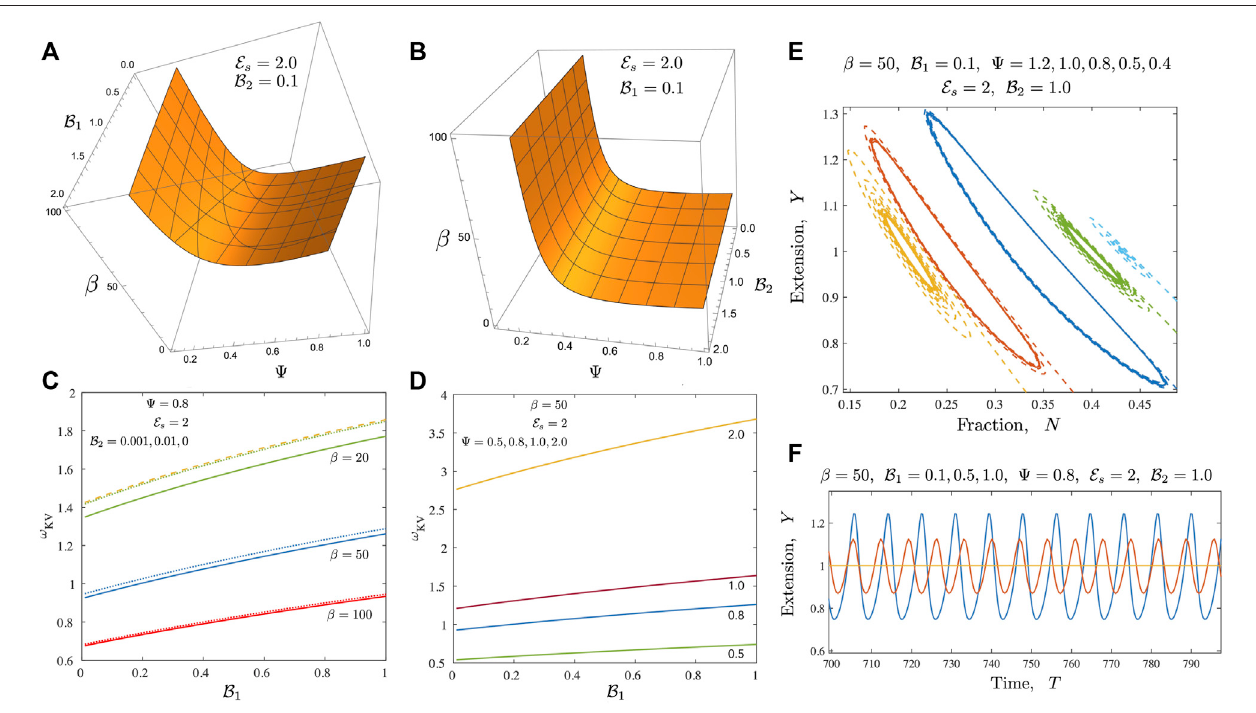
FIGURE 5 | Results for the case of a Kelvin-Voigt medium (A,B) Neutral stability curves from the linear stability analysis shown here for the Newtonian case when F (cid:2) cosh ( E ) . Typically there are critical values of Ψ (for fi xed β ), or of β (for fi xed Ψ ) below which the base state is always stable. As plotted, the region on the concave s Y side of the surface is linearly unstable. (C) and (D) Plots of the emergent frequencies (at onset) corresponding to Equation 26 , also obtained from the linear stability results. (E) and (F) Time-dependent long-time solutions obtained from a full non-linear solution to the ode system. In (E) we show phase-plots in Y − N space that demonstrates how seeoscillations existonly forarange of Ψ values(with otherparameters fi xed).Subplot (F) demonstrates howincreasing B 1 increasesthefrequency, and reduces the amplitude of the oscillations. Eventually at large values there is no instability.